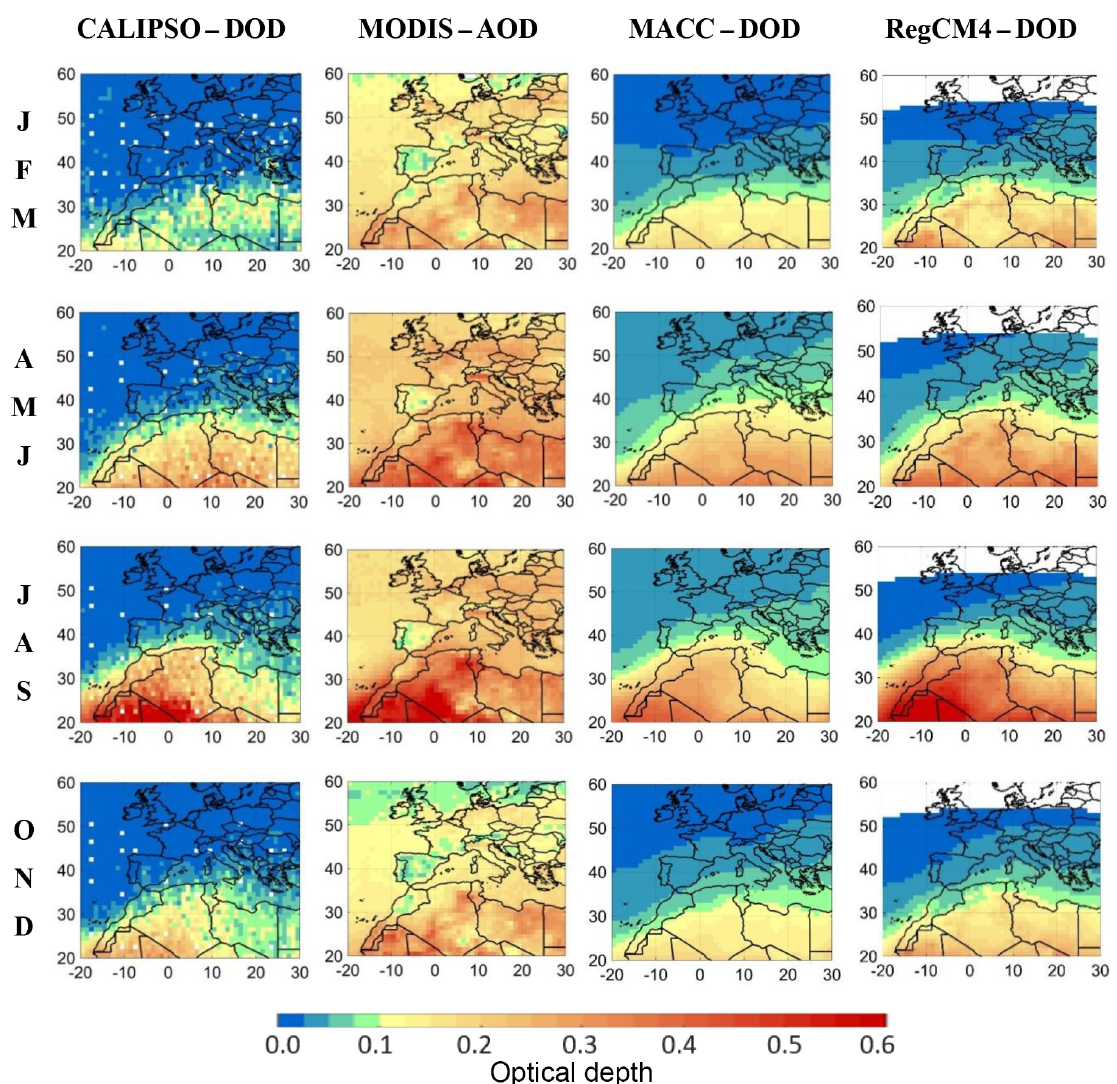
Figure 3. Comparison of the seasonal spatial distribution of the optical depth as received by (first column) pure-dust CALIPSO DOD product, (second column) MODIS AOD product, (third column) MACC reanalysis DOD product, (fourth column) RegCM4-simulated DOD